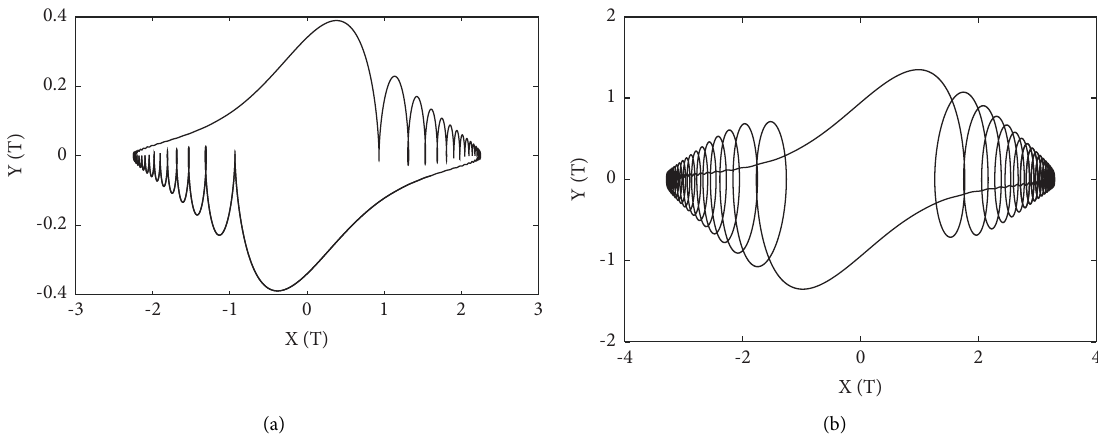
Figure 14: Phase portraits of the periodic (a) and chaotic (b) bursting oscillations of the system obtained in the MATLAB environment for parameters of Figures 7(a) and 8(a),